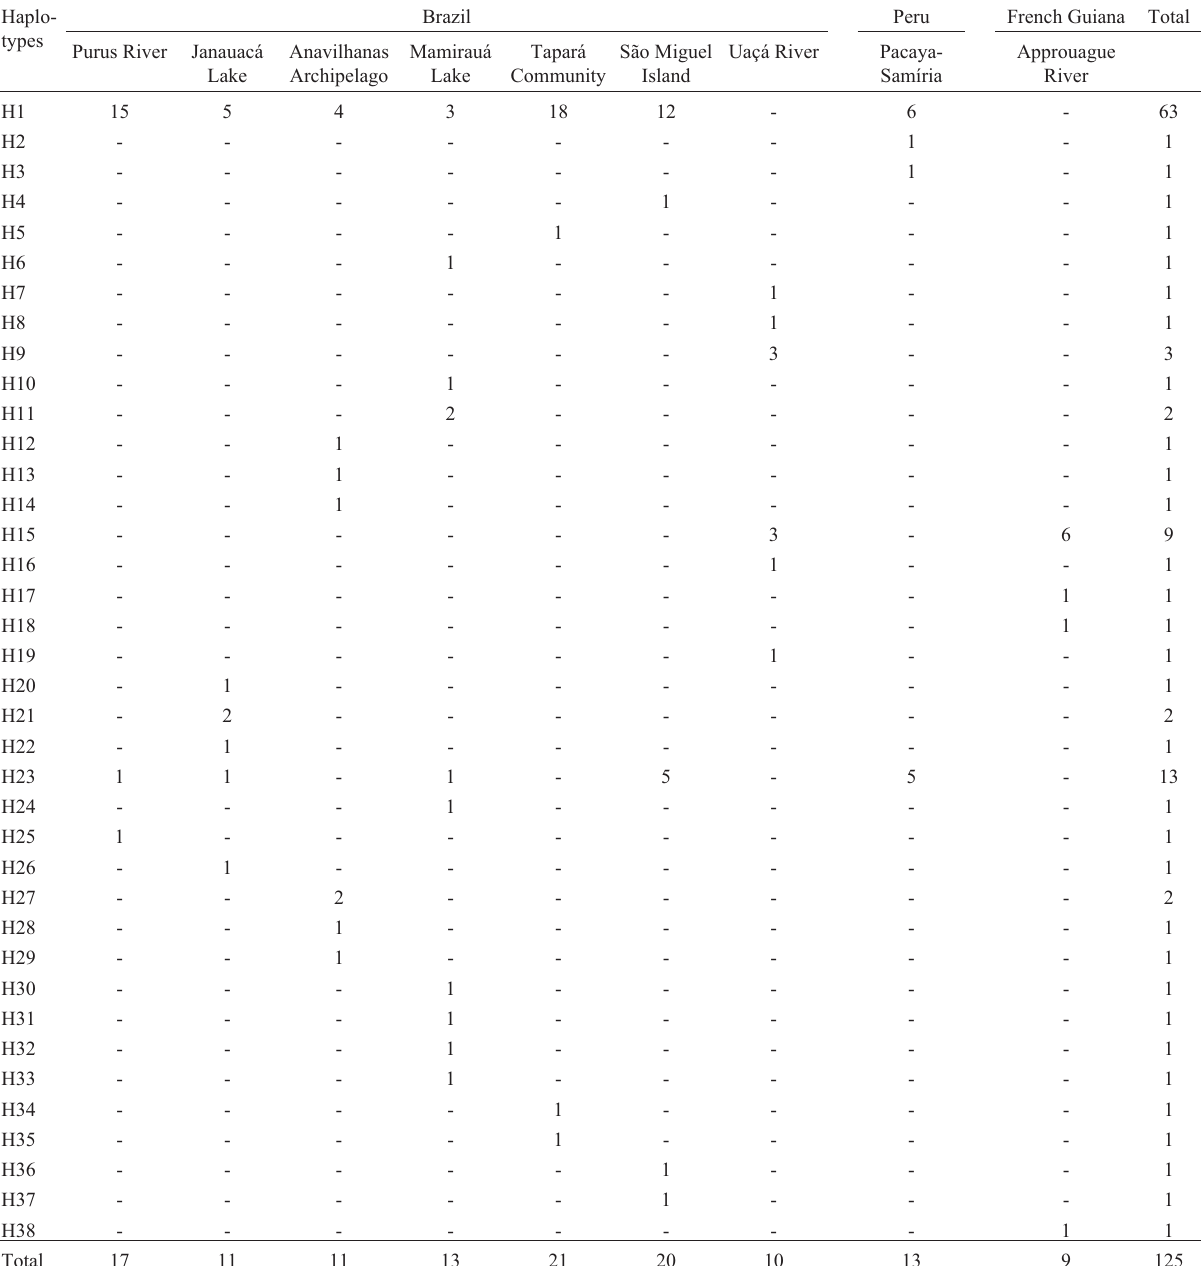
Table 2 - Haplotype frequencies of the mitochondrial cytochrome b gene in sampling localities of C. crocodilus . Haplo-